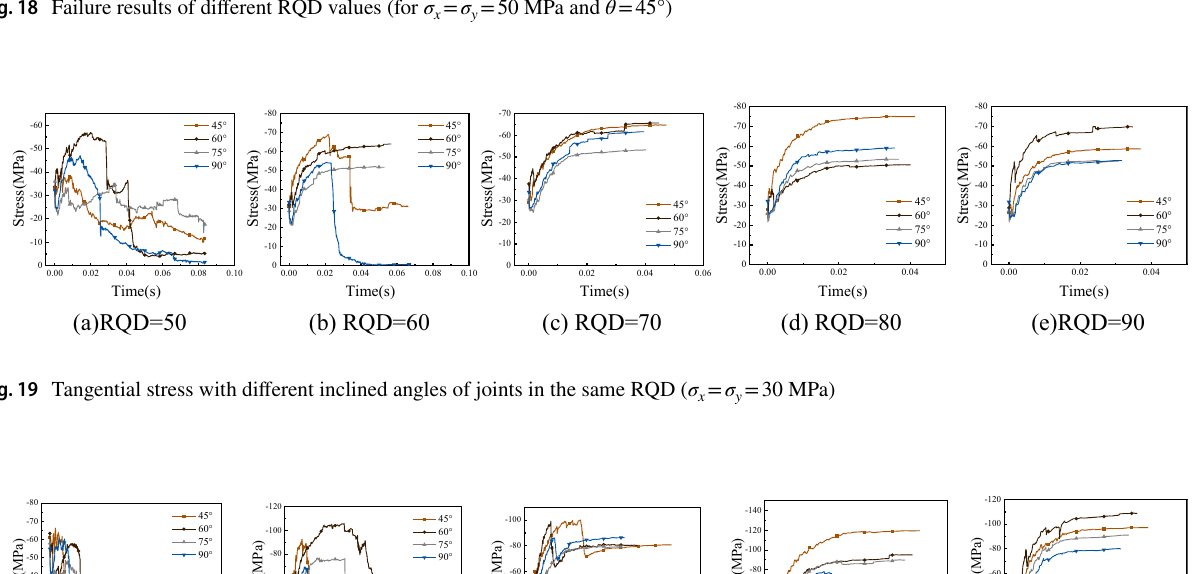
x = σ y = 50 MPa and θ = 45°)